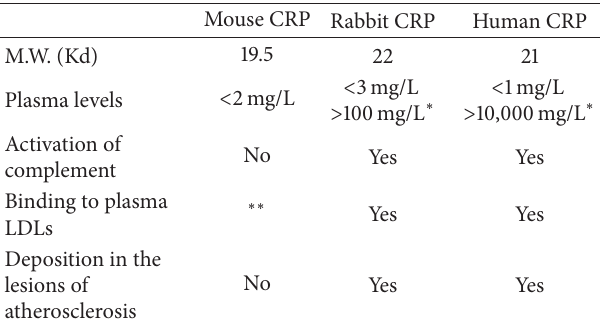
Table 2: Comparison of CRP in different